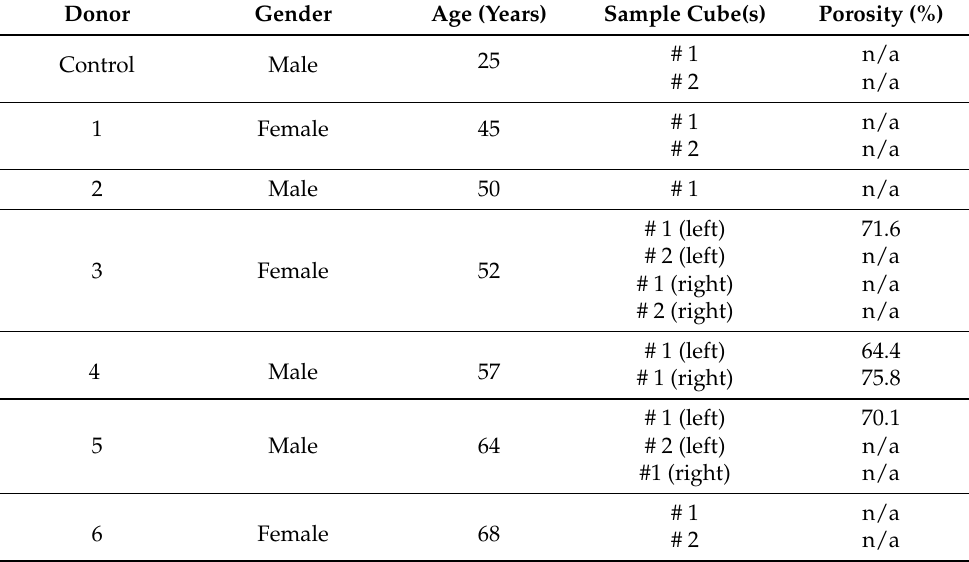
Table 1. Specifications of sample cubes, as well as porosity values obtained through micro-CT (n/a indicates those samples that were not assessed with this